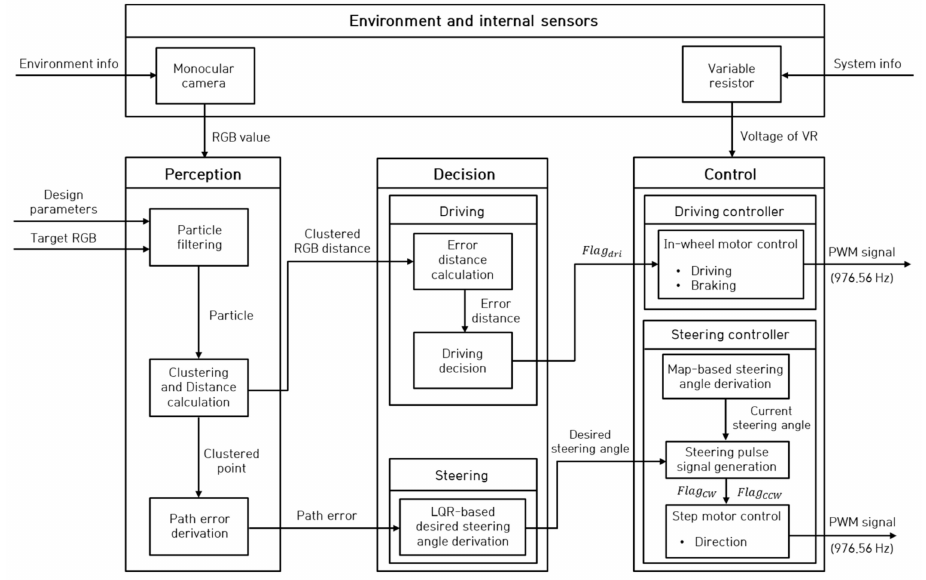
Figure 1. Overall block diagram of the path tracking algorithm.